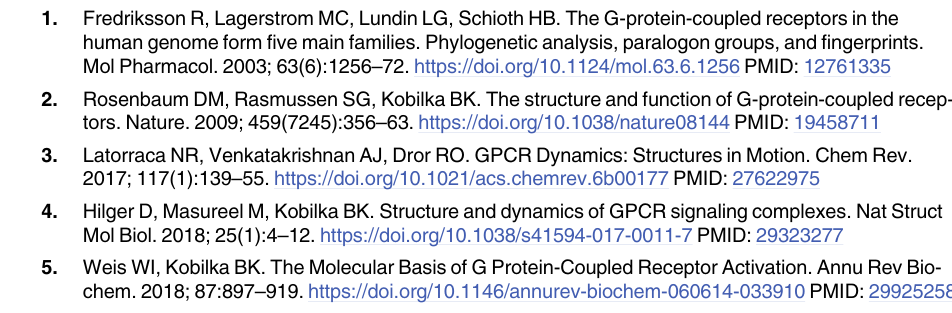
S26 Fig. Boxplots of receptor characteristics from MD simulations of adenosine A2a recep- tor (A2aR) in apo or with bound adenosine (ADN) or NECA in three different membranes. Top row: inter-helical distances between: residues R 3.50 and Y 7.53 (TM3-TM7), and ionic lock residues R 3.50 and E 6.30 (TM3-TM6); bottom row: vertical movements of extracellular loop 2 (ECL2) and TM3, respectively. MD simulations in DOPG or DOPC were performed in qua- druplicate. MD simulations in POPC were performed in duplicate. S1 Table. Adenosine A2a receptor crystal structures. S2 Table. Comparison of A2aR crystal structure distances. Comparison of TM3-TM6, TM3-TM5 and TM3-TM7 inter-helical distances in active, intermediate and inactive crystal states. S3 Table. Evaluation of G α s protein docking. Comparison of best docking quality of G α protein into inactive, intermediate and active crystals structures, and different MD-generated conformations of A2aR achieved under different conditions and performed in